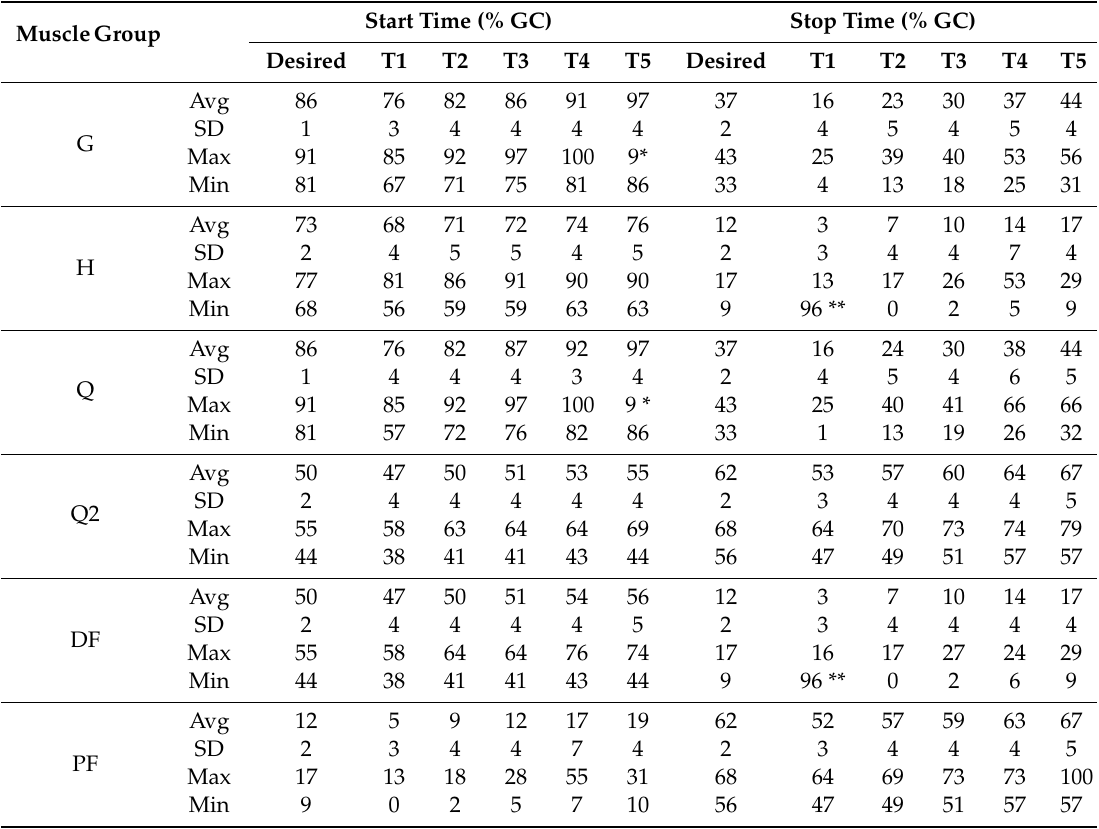
Table 3. Descriptive statistics of desired stimulation timing (DESIRED) and the stimulation timing for five trigger conditions as a percentage of the gait cycle (% GC).